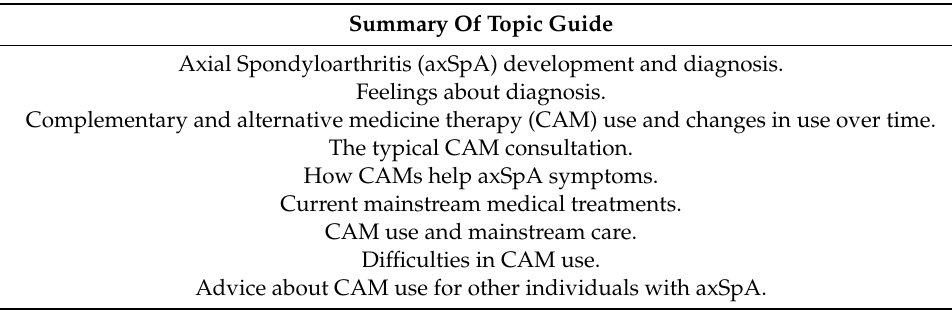
Table 1. Summary of topic guide a